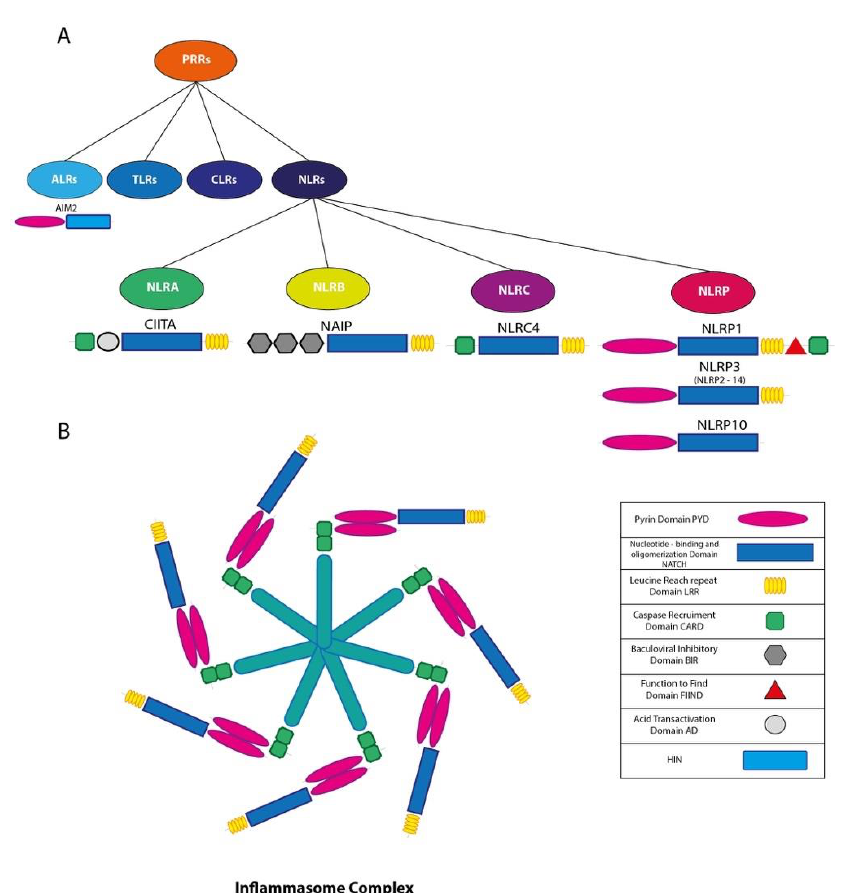
Figure 1. ( A ) Schematic representation of Pattern Recognition receptors (PRR) and nucleotide-binding oligomerization domain (NOD)-like receptors (NLRs); ( B ) schematic representation of inflammasome complex.